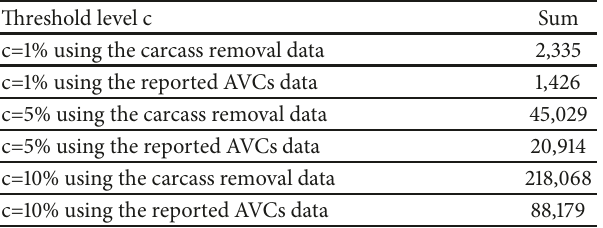
Table 14: The sum of difference in ranks over all identified sites for threshold level 𝛼 using the carcass removal data and the reported AVC data using the GNB-based EB